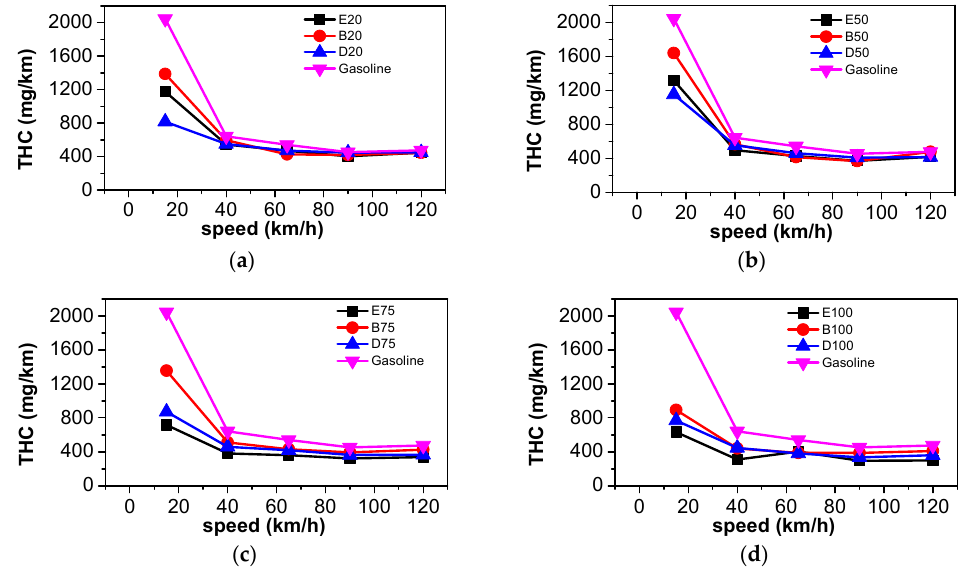
Figure 8. Comparison of THC emissions of different fuels at different blending ratios: (a) 20% blending ratio; (b) 50% blending ratio; (c) 75% blending ratio; and (d) 100% blending ratio.